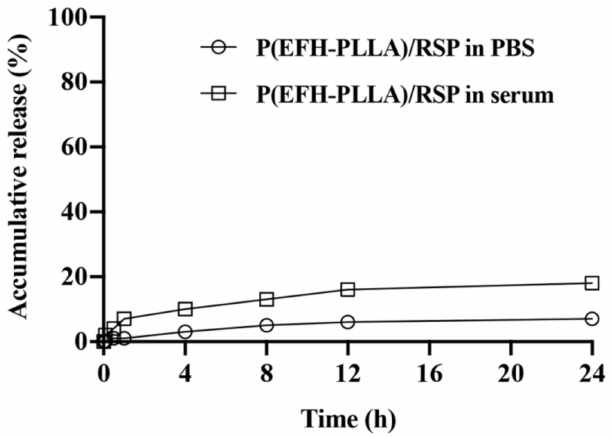
Figure 5. Release of risperidone (RSP) from PEGylated P(EFH-PLLA) / RSP nanoparticles (NPs) in a phosphate bu ff ered saline (PBS) and human serum at 37 ◦ C over a 24 h period. Each data point represents the mean of three